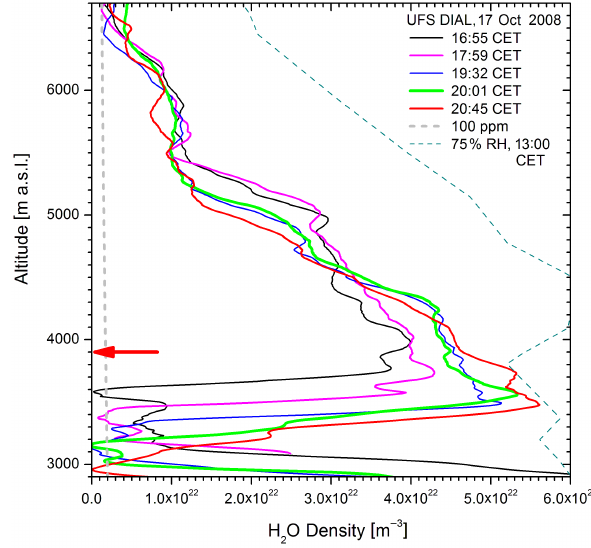
Figure 8. Ozone and RH profiles during the sonde ascent launched at Lindenberg at 18:44CET; for the RH of the RS92 sonde the final GRUAN data product was taken.